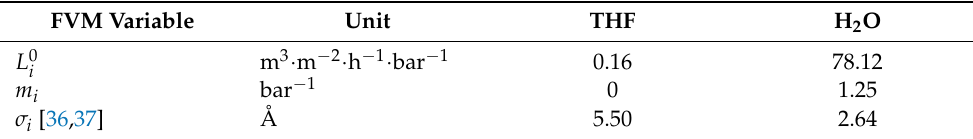
Table 2. Parameters of the free-volume model (FVM) [35] for the 20 mass percent THF–H 2 O mix- ture separation.